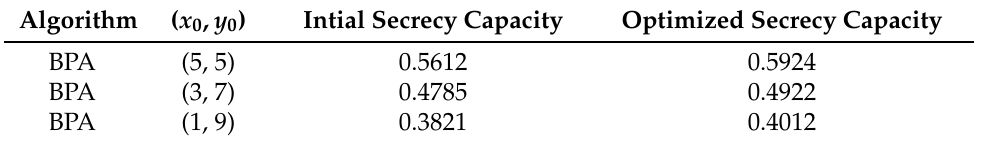
Table 11. Influence of the Initial Point on Secrecy Capacity